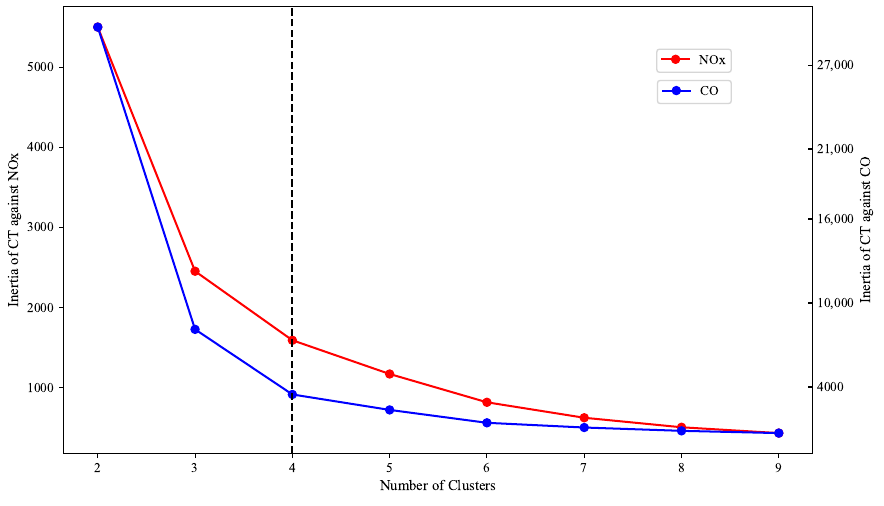
Figure 17. Cluster number determination using elbow method.